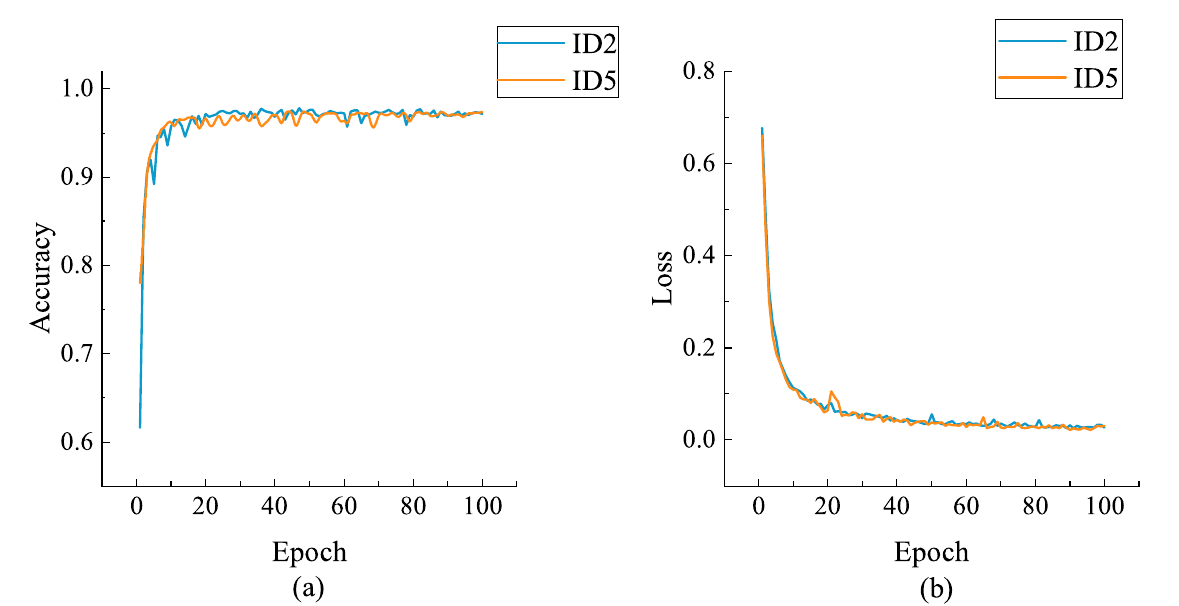
Figure 14. Accuracy curves and loss curves of ID2 and ID5 during training session: ( a ) the accuracy curves; ( b ) the loss curves.